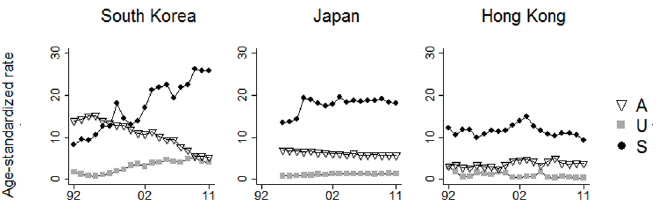
Fig 3. Age-standardized rates of suicide, undetermined death, and accident in South Korea, Japan, and Hong Kong from 1992 to 2011.